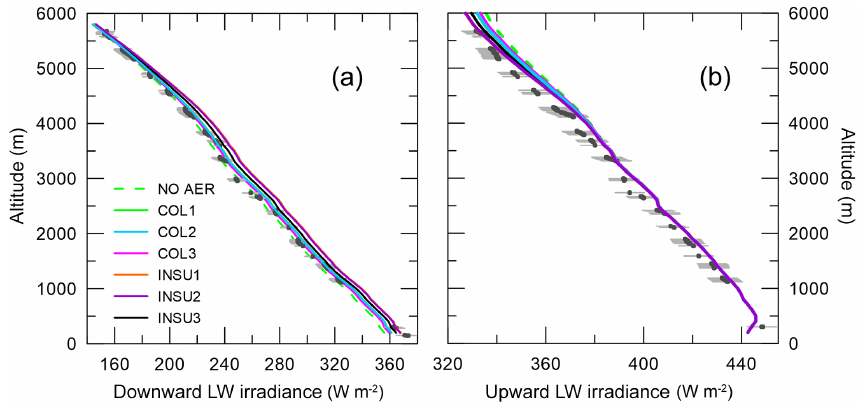
Figure 6. (a) Downward and (b) upward LW irradiance profiles for F35. Grey dots are the measurements selected for small pitch and roll angles, with the associated uncertainty (1 σ ) in light grey. Simulated profiles with different PSDs and RIs are shown in different colours. See text for details.